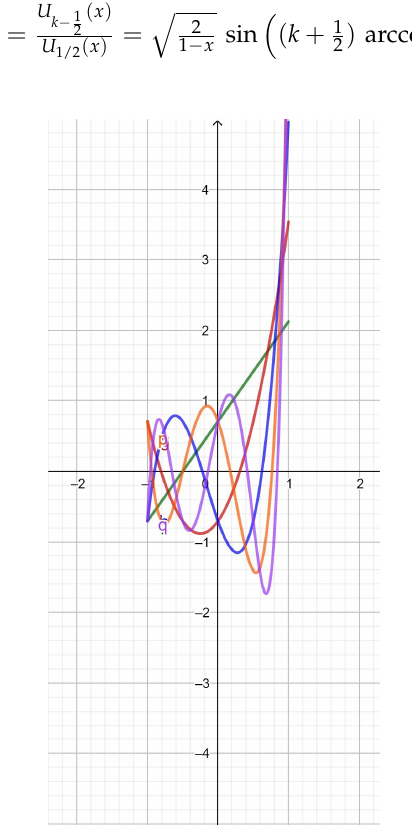
Figure 4. W k ( x ) , k = 1,2,3,4,5. 1, green; 2, red; 3, blue; 4, orange; 5,